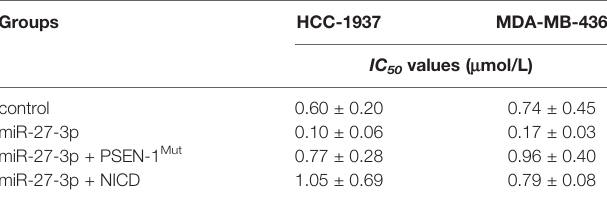
TABLE 1 | miR-27-3p enhances the sensitivity of TNBC cells to Olaparib. Groups